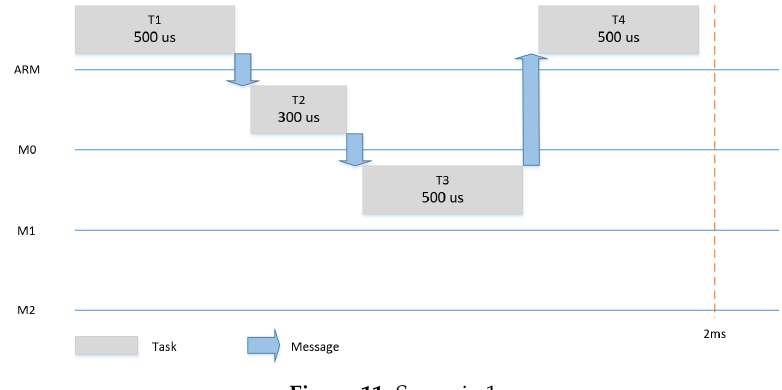
Figure 11. Scenario 1.